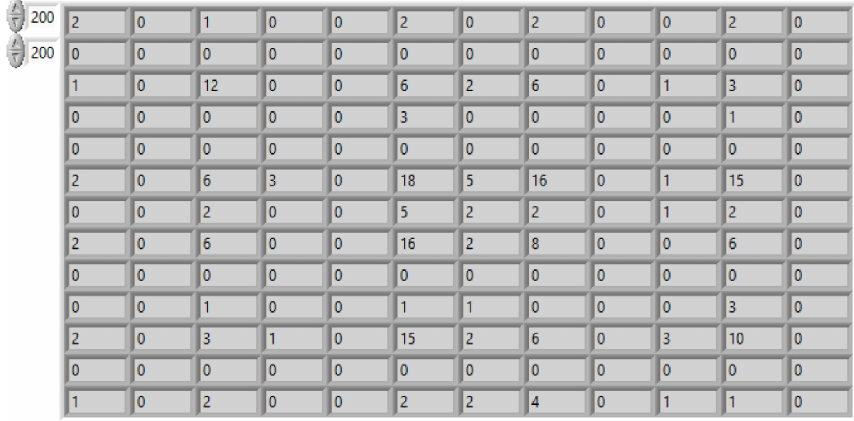
Figure 14. Final result of combination original image ( a ), segmented ( b ) and ( c ) Final.